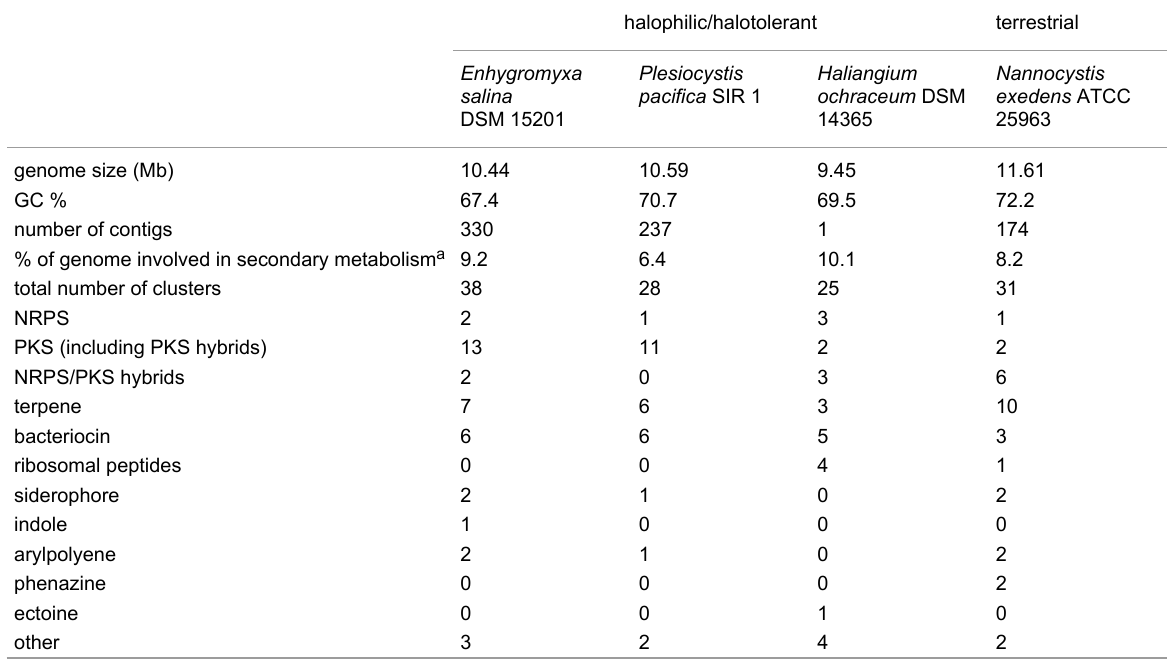
Table 1: Summary of antiSMASH analysis (version 3.0.4) of the four available genomes of myxobacteria of the suborder Nannocystineae.